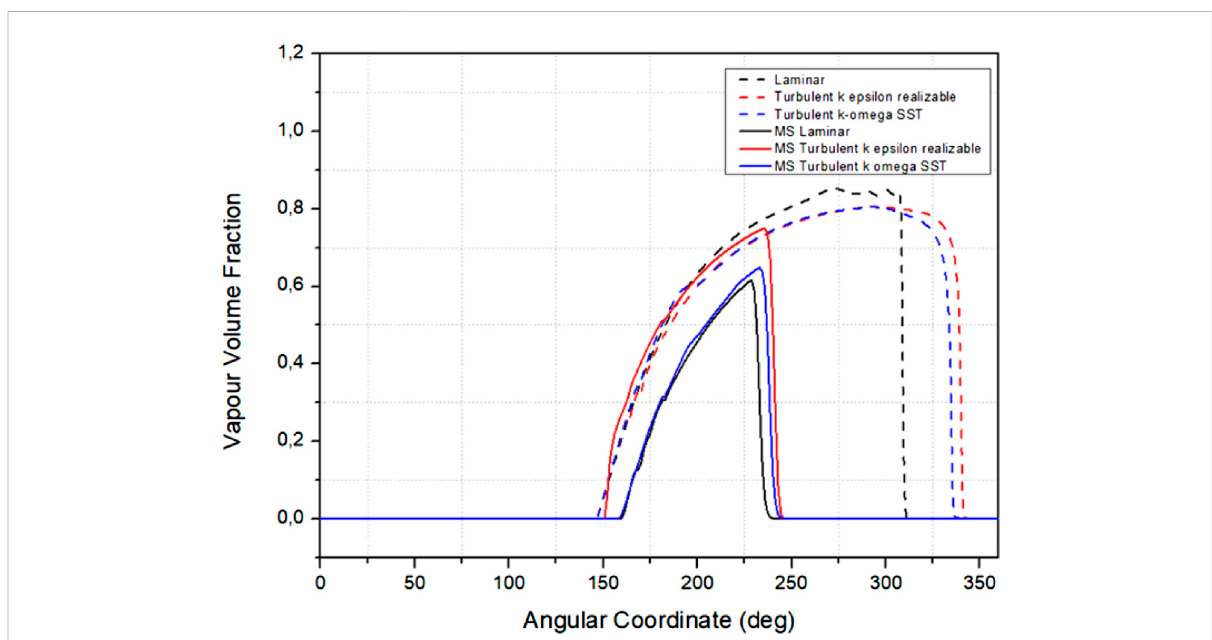
FIGURE 10 Plot of the vapor volume fraction at the midplane stationary wall multistep groove and smooth journal bearing, ε = 0.7 dan ω = 3,000